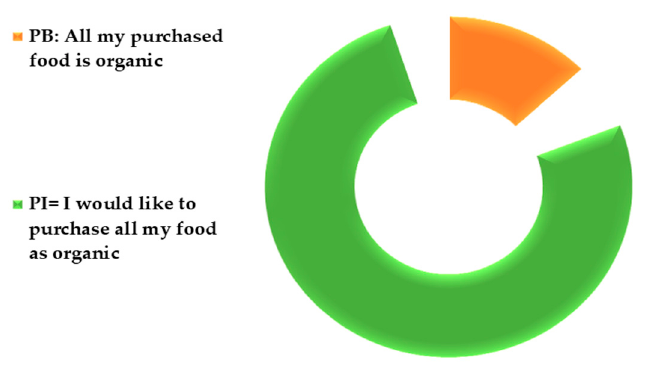
Figure 6. The percentage of consumers who held intentions to buy all their food as organic (PI: purchase intentions) versus the percentage of consumers who reported to purchase all their food as organic (PB: purchase behavior).